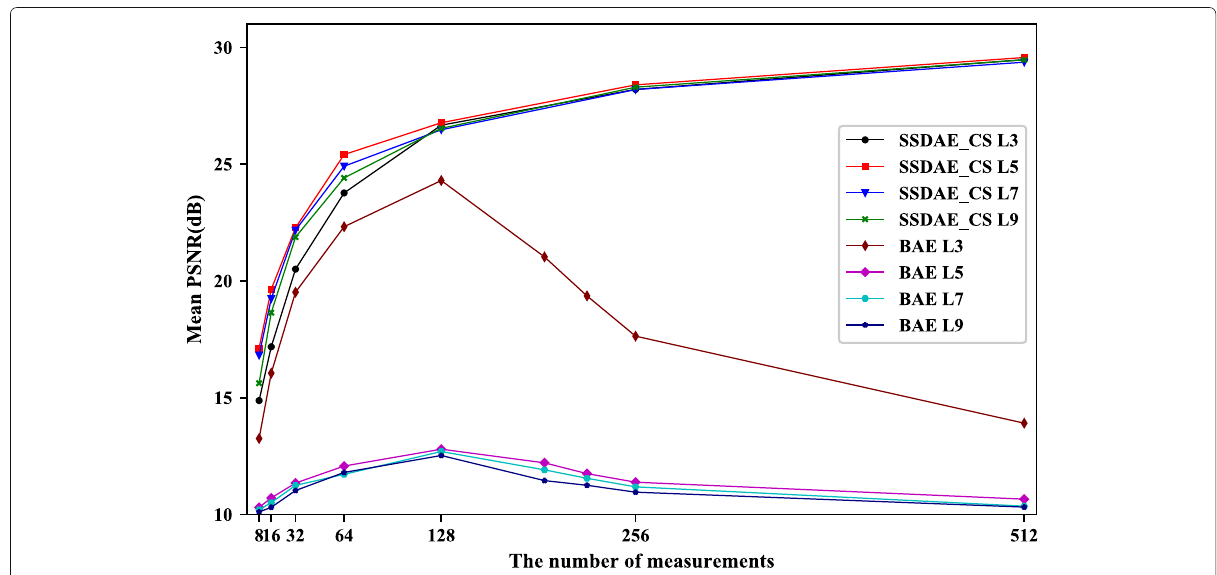
Fig. 3 The experimental results of compared BAE with SSDAE_CS